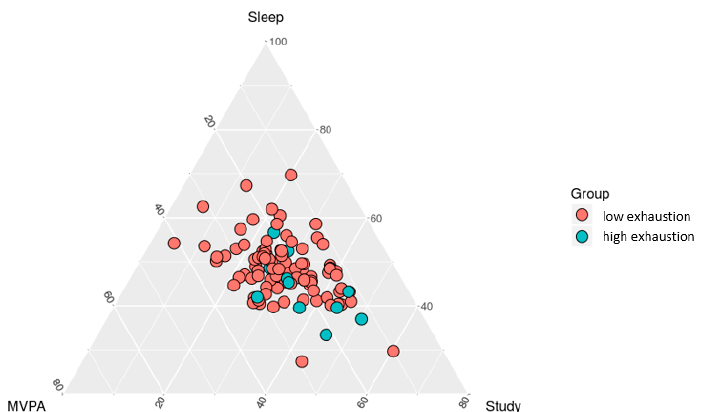
Figure 1. Ternary plot of the sample composition of time spent in sleep, MVPA, and study. Colored points represent groups of low ( red ) and high emotional exhaustion ( blue ).